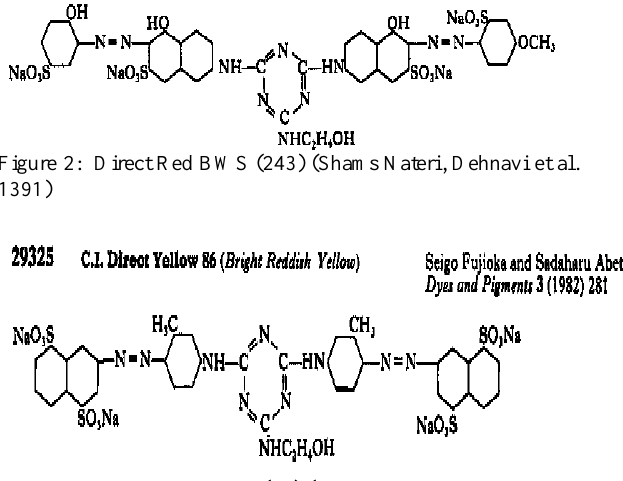
Figure 3: Direct Yellow RL (86) (Shams Nateri, Dehnavi et al. 1391)